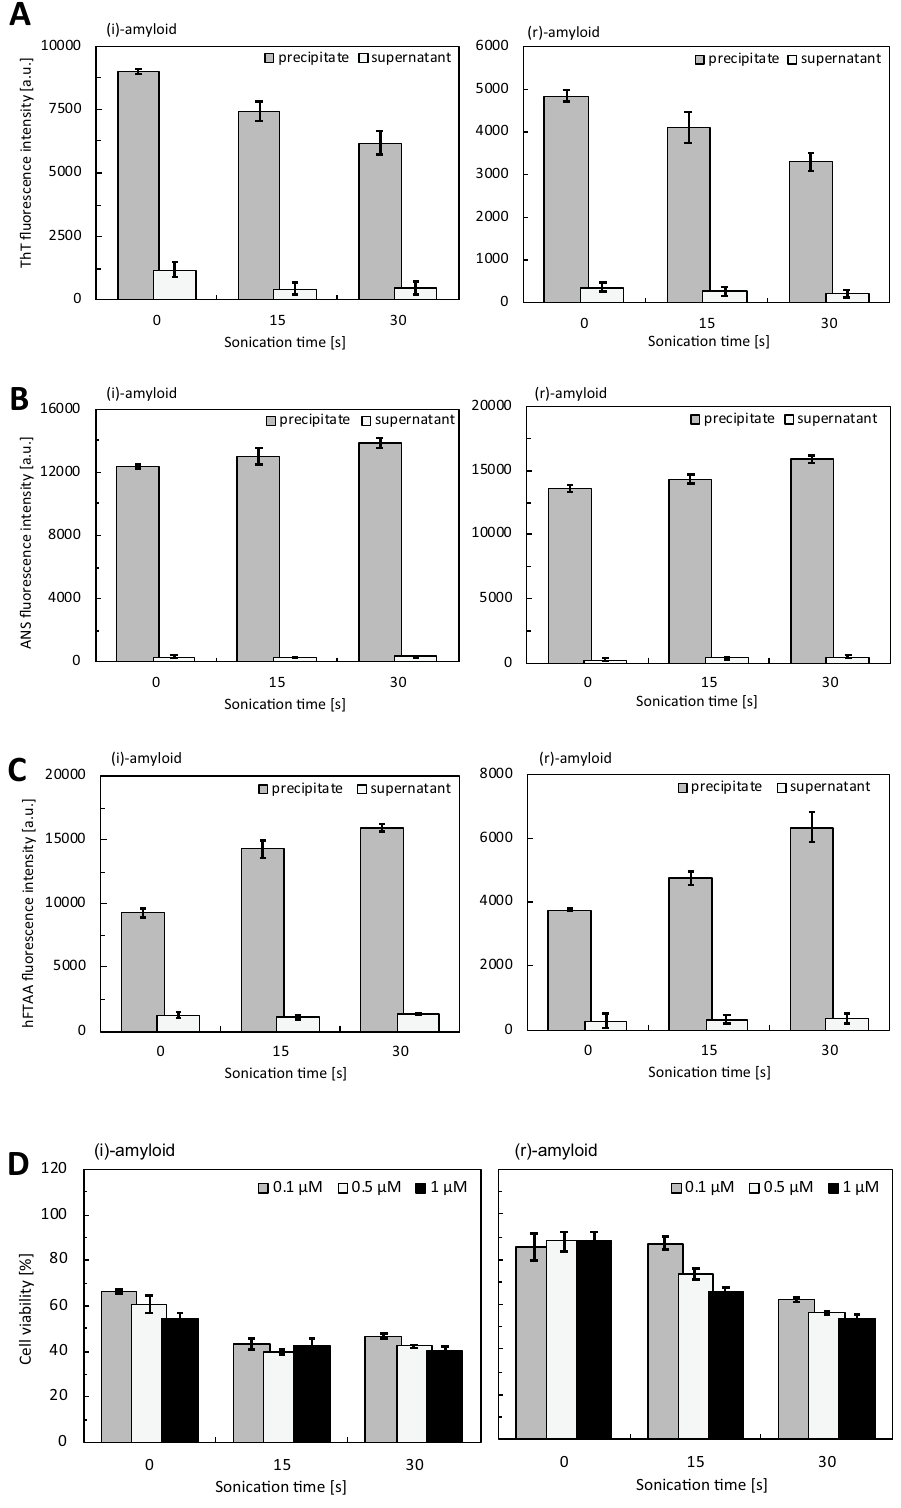
Figure 4. Structure and toxicity of the sonicated insulin amyloids. The (i)-amyloid (left) and (r)-amyloid (right) samples were sonicated for the indicated time, and the precipitate and supernatant samples were evaluated by ThT ( A ), ANS ( B ), and hFTAA ( C ). Peak fluorescence values at 490 nm (ThT), 480 nm (ANS), and 560 nm (hFTAA) are shown; precipitate (gray), and supernatant (white). Protein concentrations were adjusted to 5 µM. ( D ) Cytotoxicity of the sonicated (i)-amyloid (left) and (r)-amyloid (right). All samples were quantified by BCA assay and were diluted to the same protein concentration: 0.1, 0.5, and 1 μM (white, gray, and black, respectively) The absorbance was normalized for PBS as